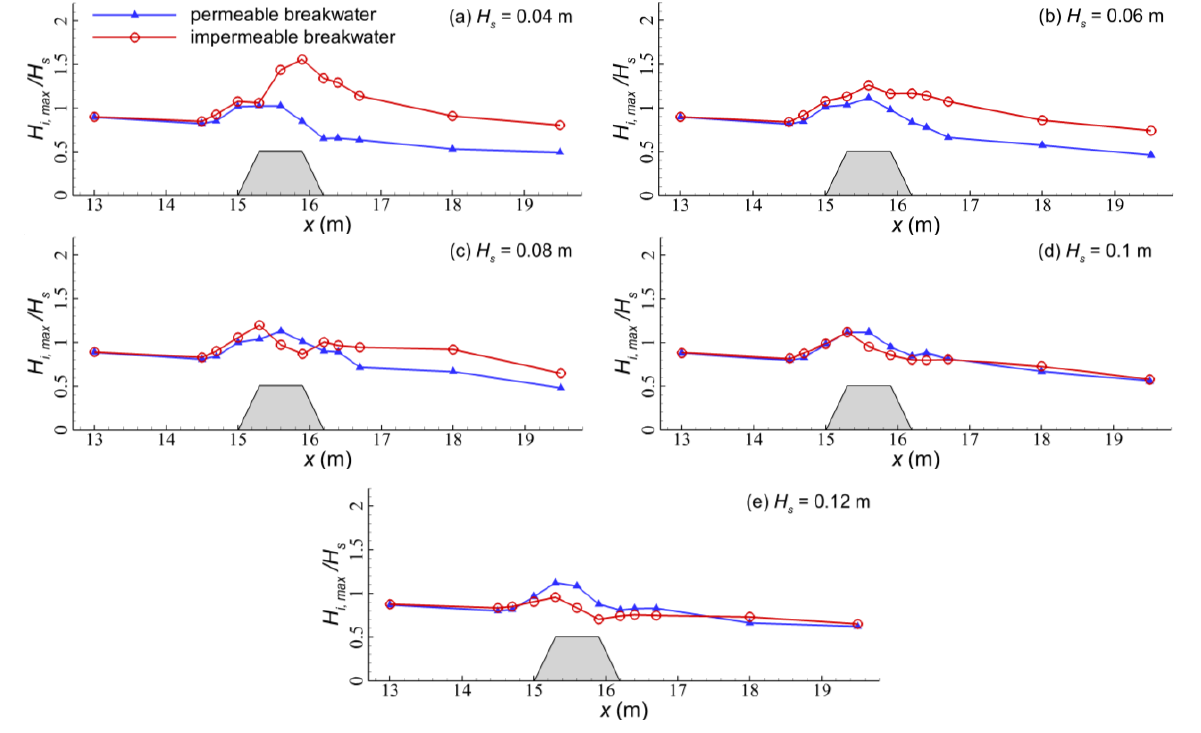
Figure 14. Spatial distribution of the maximum wave heights with different significant wave heights.